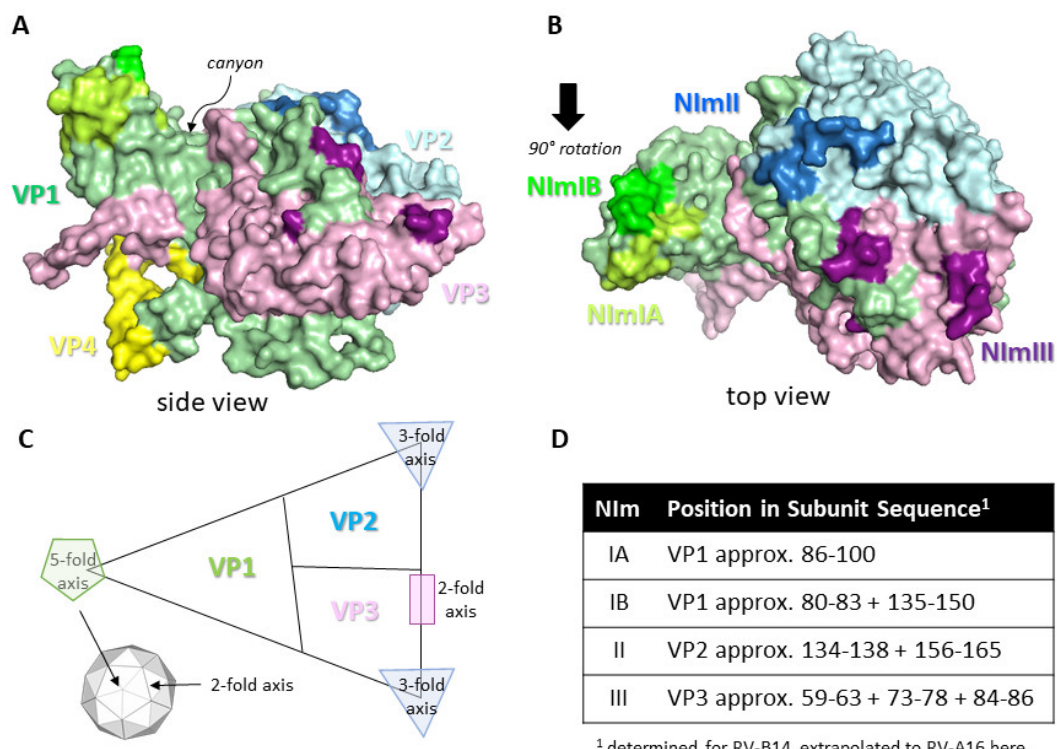
Figure 1. Protomer structure of RV-A16 and neutralising sites for Abs. Coordinates for RV-A16 protomer structure (1AYM) were downloaded from the protein data bank at www.rcsb.org and images created using PyMol molecular graphics system version 2.3.2 (Schrodinger LLC). ( A , B ) shows the protomer structure with VP1 (green), VP2 (light blue), VP3 (pink), and VP4 (yellow). Neutralising immunogenic (NIm) regions are highlighted light green (NIm-IA), lime green (NIm-IB), blue (NIm-II), and purple (NIm-III). The canyon region is identified in the side view shown in ( A ). ( C ) Schematic diagram of the RV capsid protomer showing approximate locations of the VP1, VP2 and VP3 subunits and the three axes of symmetry, including their position within the RV capsid icosahedron (smaller inset). ( D ) Location of NIm sites within each capsid protein subunit of RV-A16. Numbering refers to each individual capsid subunit amino acid sequence. NIm-IA is the only known linear sequence whereas the remaining NIms are discontinuous epitopes.